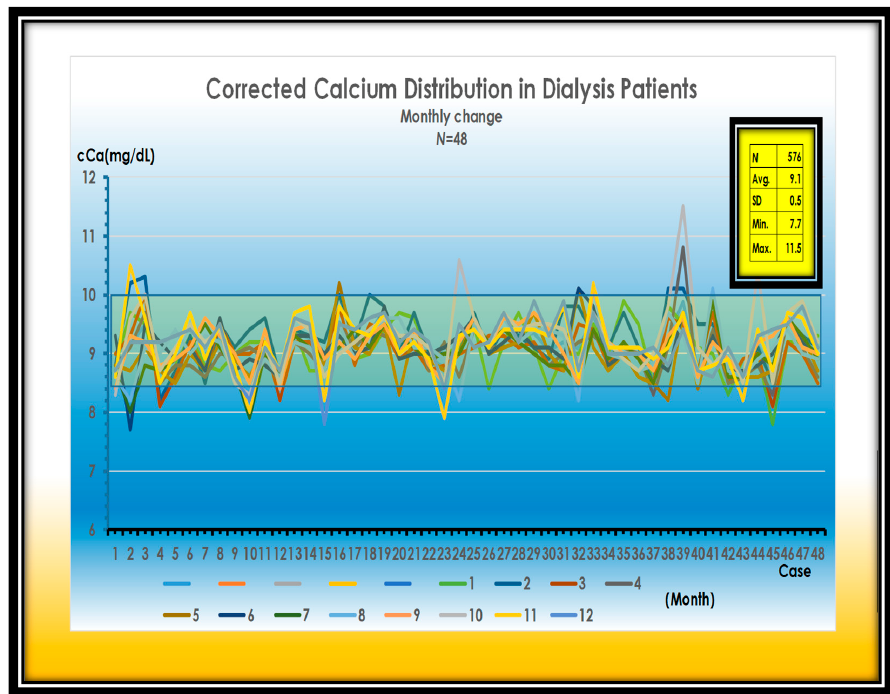
Figure 3. Changes in cCa levels in 48 dialysis patients. Average of cCa is 9.1 mg. SD is 0.5 mg/dL. Maximum of cCa is 11.5 mg/dL. The attainment of the adequate value of cCa is almost 100%, which is a result of making full use of the CaSREs (Figure